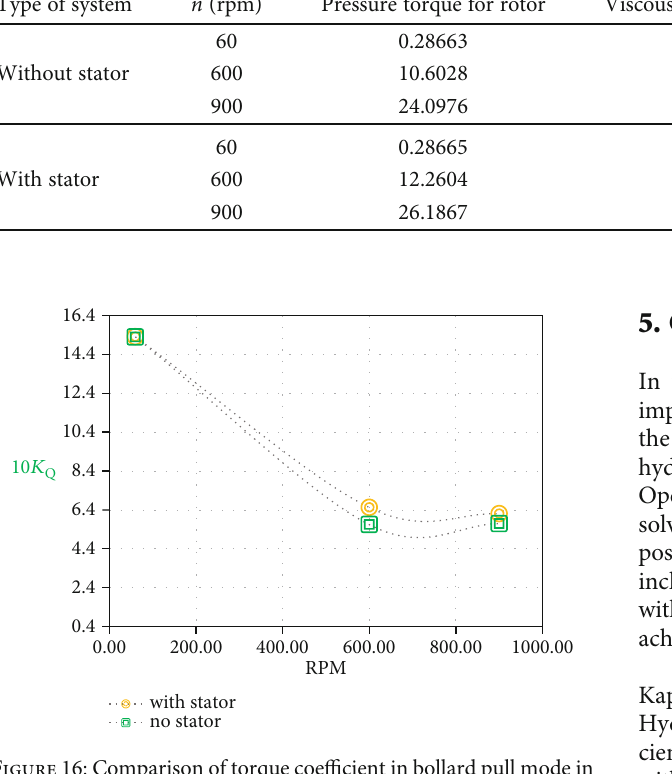
Table 13: Torque force calculated for the linear jet system in bollard pull mode. Type of system